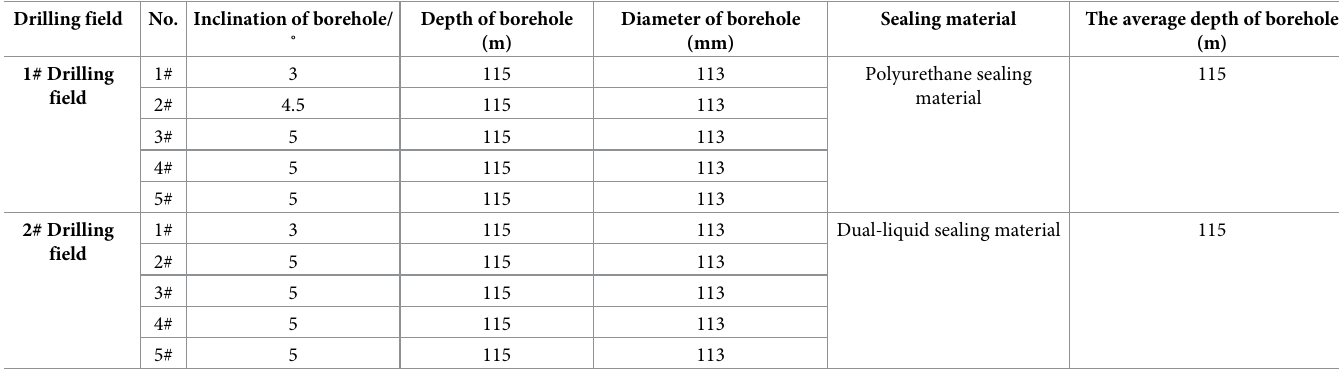
Table 4. Field test drilling construction